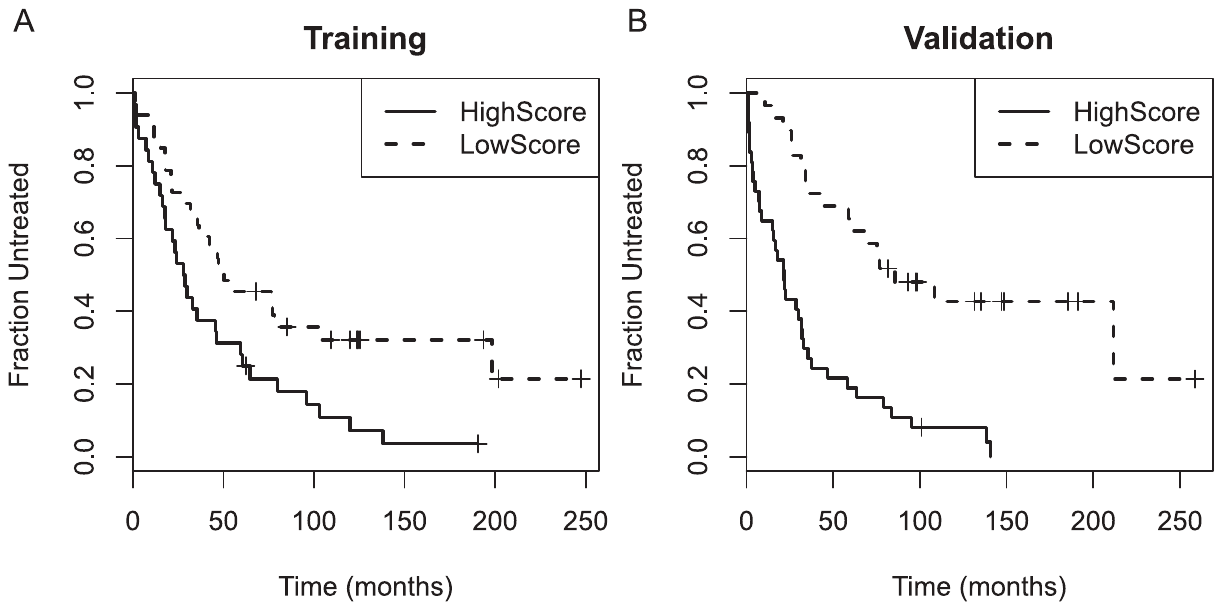
Figure 2. Kaplan-Meier plots of the time from diagnosis to treatment stratified by the gene prognostic (GP) score (a linear combination of the expression of SKI and SLAMF1 ) in (A) the training set and (B) the validation set.